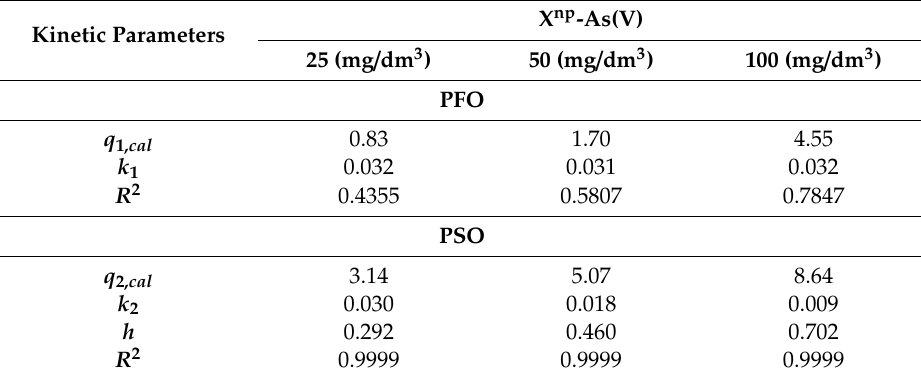
Table 4. Kinetic parameters of arsenic(V) adsorption on X np